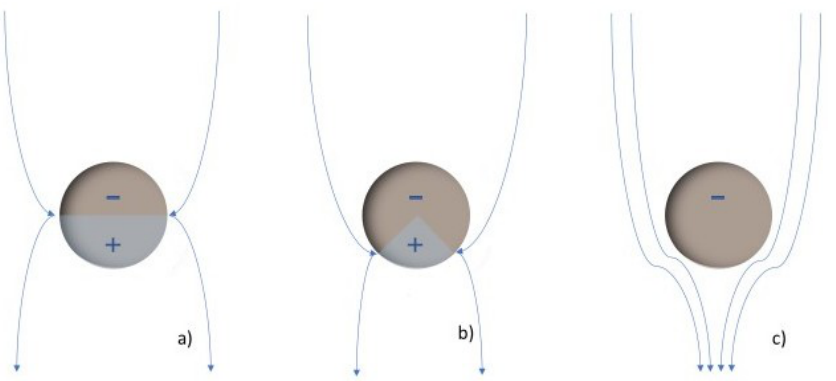
Figure 11. Polarization-charging of a nanoparticle under electric stress: ( a ) Distribution of surface charges in the nanoparticle once polarized, ( b ) increasement of the negative charge due to the capture of free electrons in surface potential wells, ( c ) saturation of the potential wells and the nanoparticle.